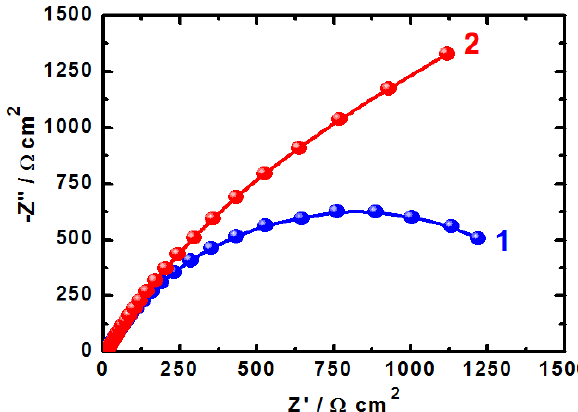
Figure 6. EIS Nyquist for (1) pure iron and (2) API X-65 steel at corrosion potential after 40 min immersion in 4.0 wt % NaCl solutions.